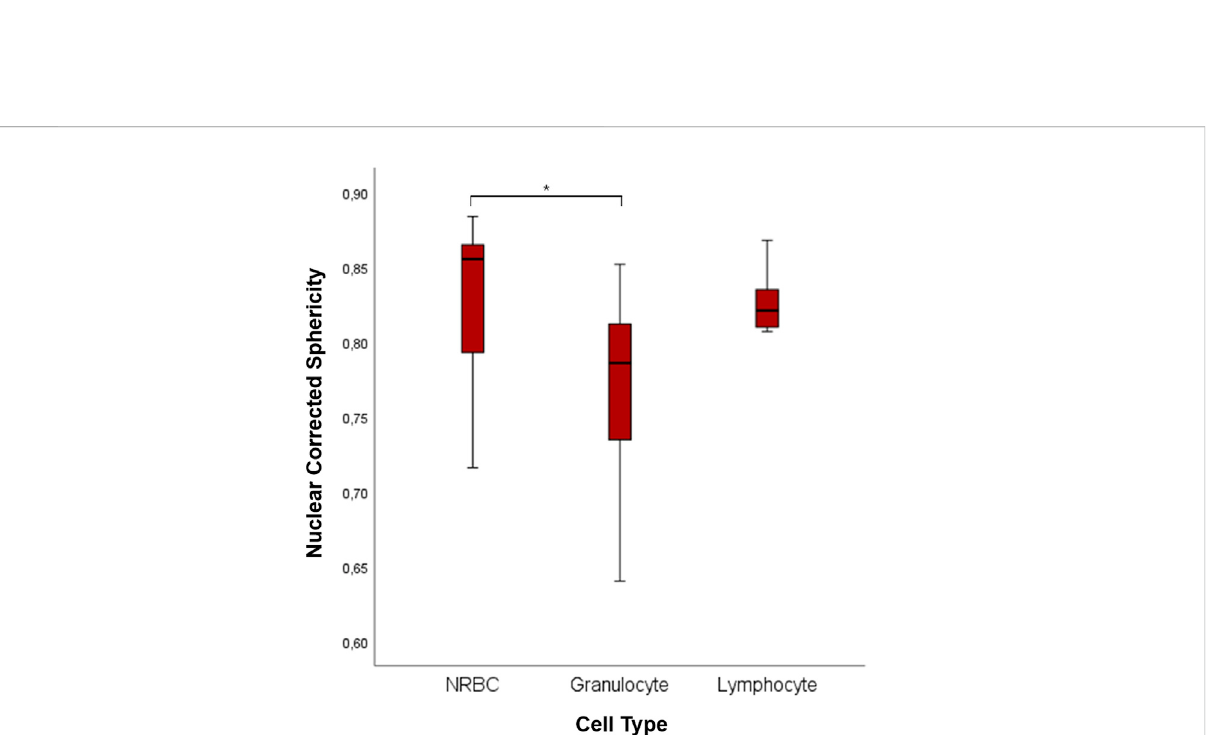
FIGURE 8 Boxplots of 3D nuclear sphericity values of NRBC, granulocyte, and lymphocyte. The symbol * represents a statistically signi fi cant difference (* p < 0.05; ** p < 0.01; *** p < 0.001).